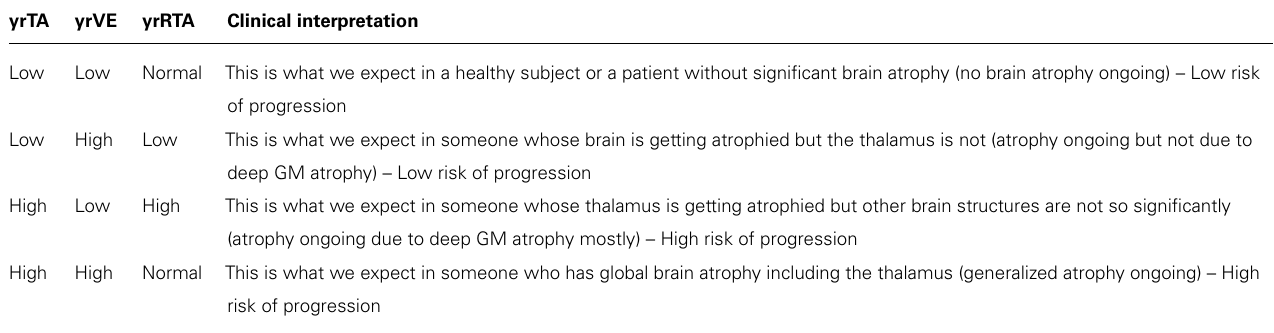
Table 2 | Possible results of the yrTA, yrVE, and derived yrRTA in qualitative terms with the clinical interpretation. yrTA yrVE yrRTA